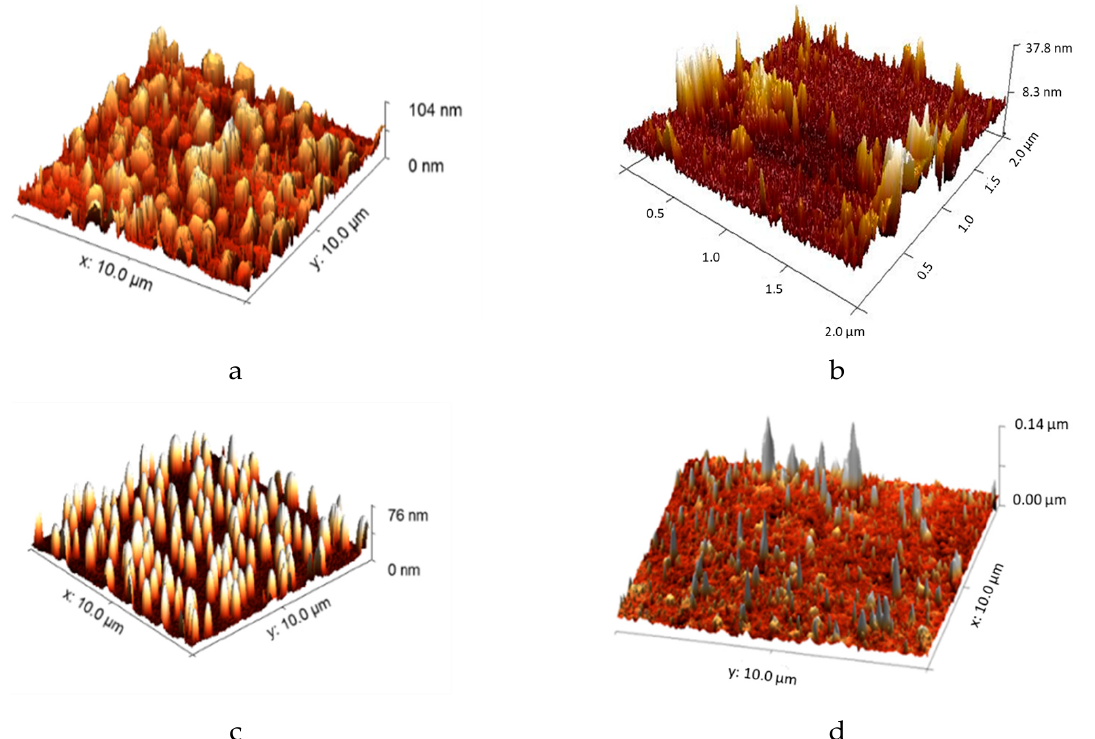
Figure 2. AFM images of the: ( a ) Nafion, ( b ) (Naf / Lys) 6 , ( c ) (Naf / Chi) 6 , and ( d ) (Naf / Lys / Naf / Chi) 2 coatings deposited on quartz crystal microbalance with dissipation monitoring (QCM-D) crystals.